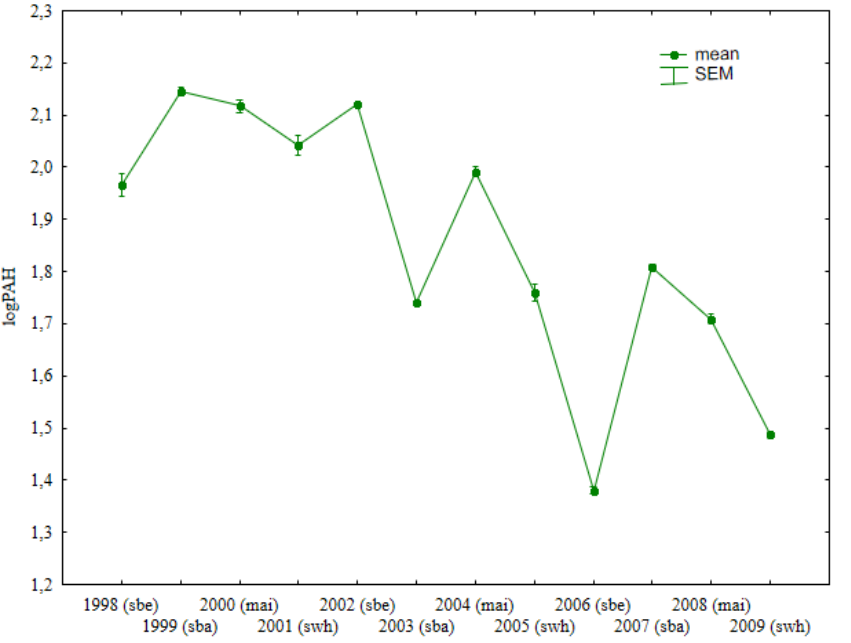
Figure 1. Total content of light PAHs in soil under different crops (log transformed data for 1998–2009). During the entire experiment, the total content of light PAHs was higher in soil fertil- ized with manure than in soil supplied with mineral fertilizers only (Figure 2, Table S3). In 1998 and 2004, the concentrations of light PAHs were similar in treatments that were and were not fertilized with manure. From 1998–2002, the content of light PAHs remained relatively stable in soil supplied with mineral fertilizers only. In the same period, treat- ments supplied with manure and mineral fertilizers differed considerably in the levels of light PAHs.